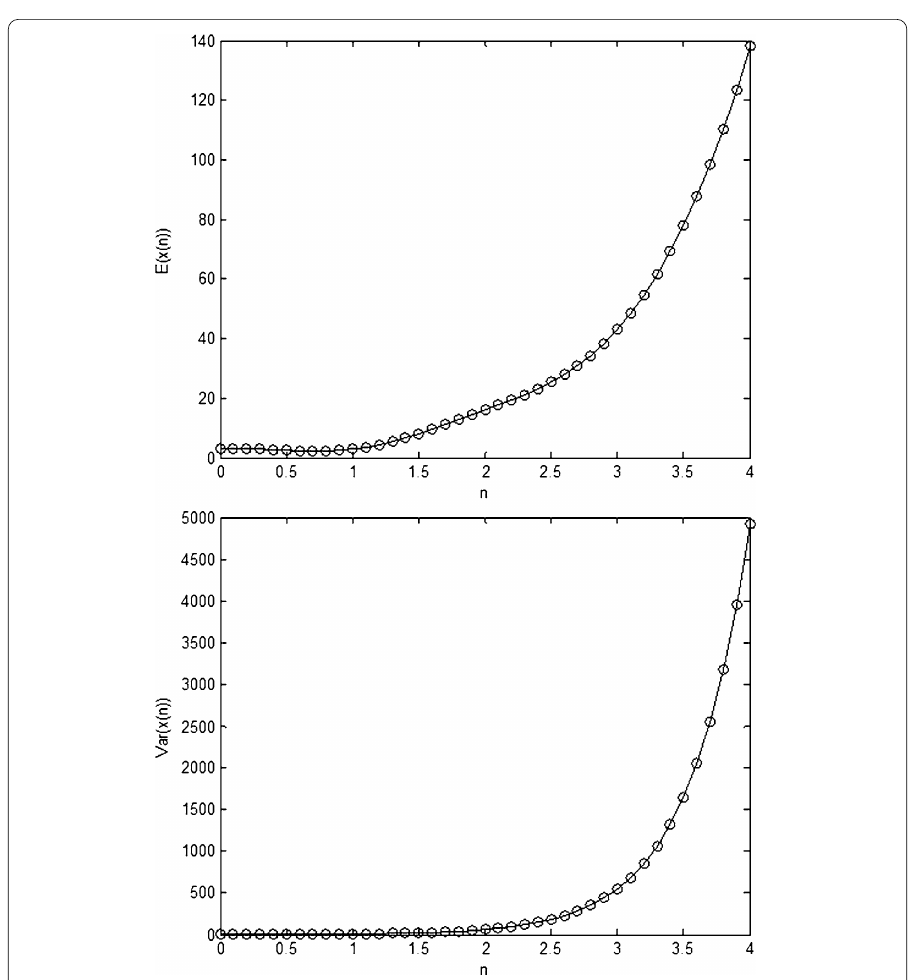
Figure 2 Expected value and variance obtained from the Z-transform of (18)